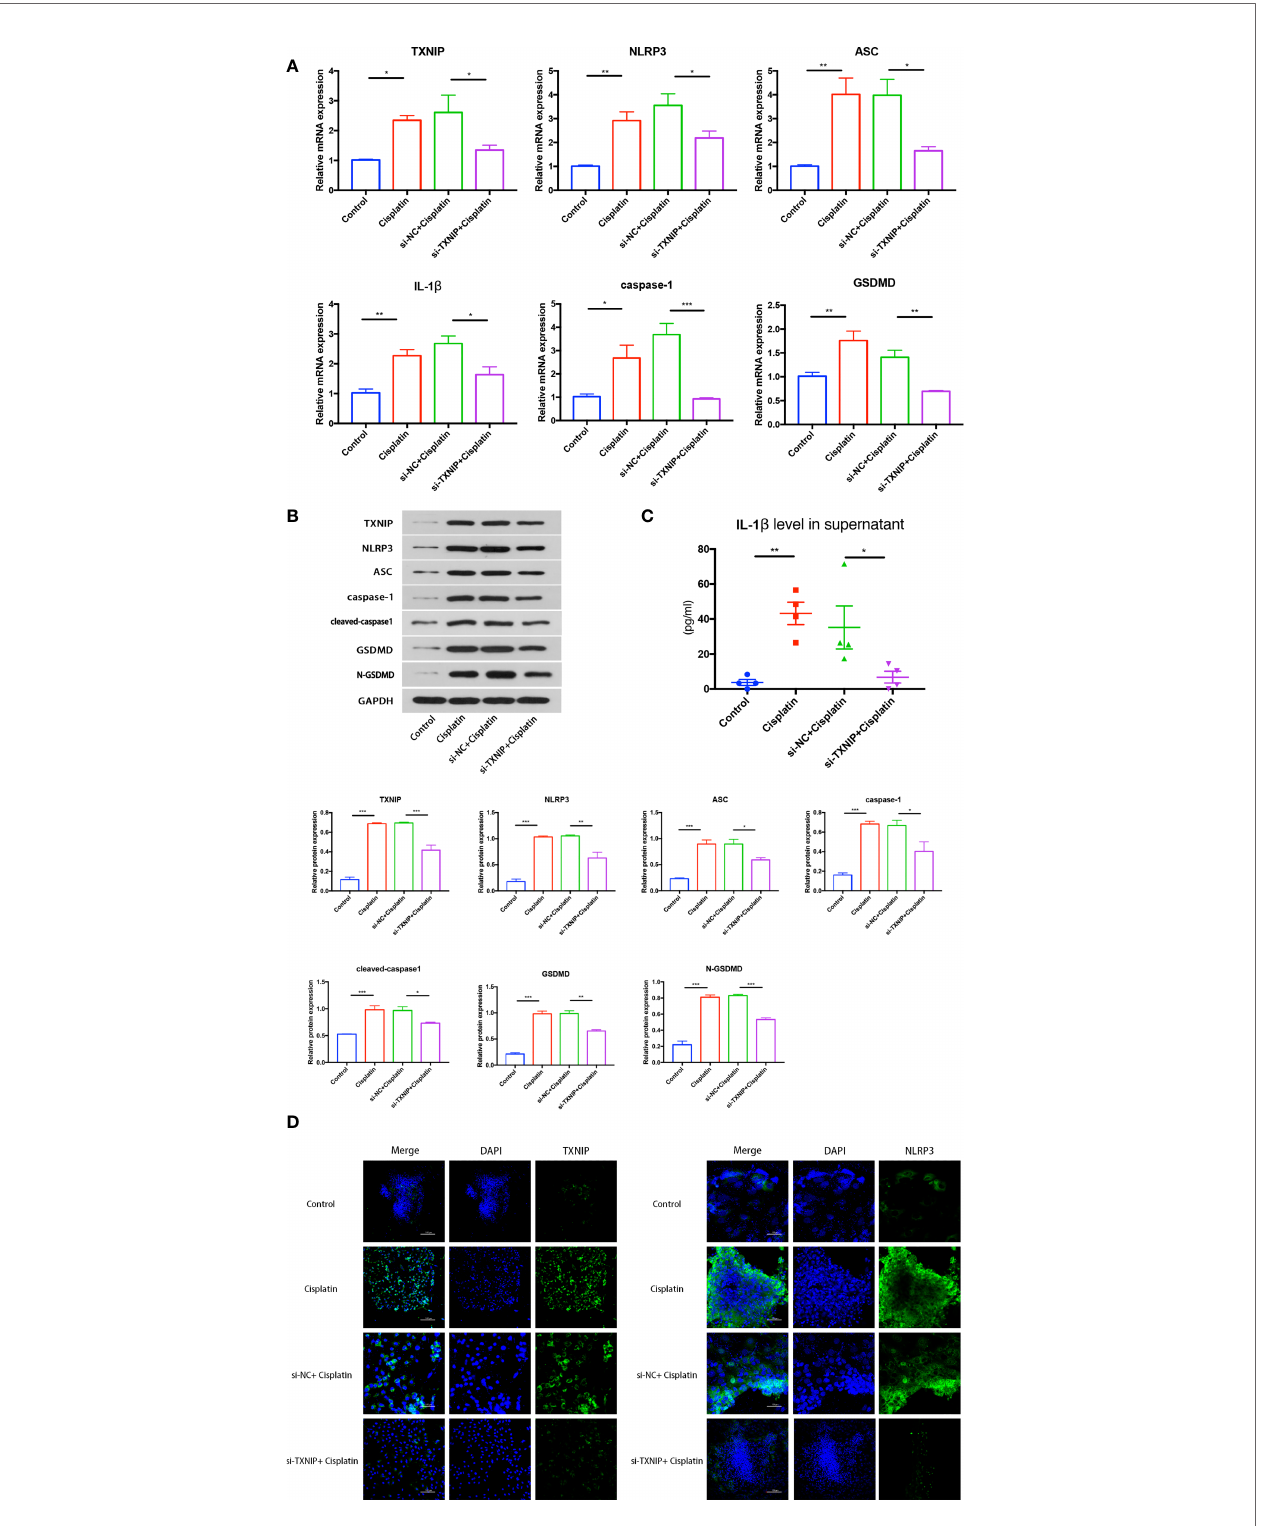
FIGURE 7 | The effect of downregulation of TXNIP on cisplatin-induced NLRP3 in fl ammasome-mediated pyrolysis-related protein expression in MCs at mRNA level (A) and protein level (B) . (C) The difference in the concentrations of IL-1 b in the supernatant in each group. (D) The variation of NLRP3 expression before and after TXNIP-siRNA transfection. Scale bars: 100 µm. Representative results of at least three repeated experiments are shown. *p < 0.05, **p < 0.01, ***p <